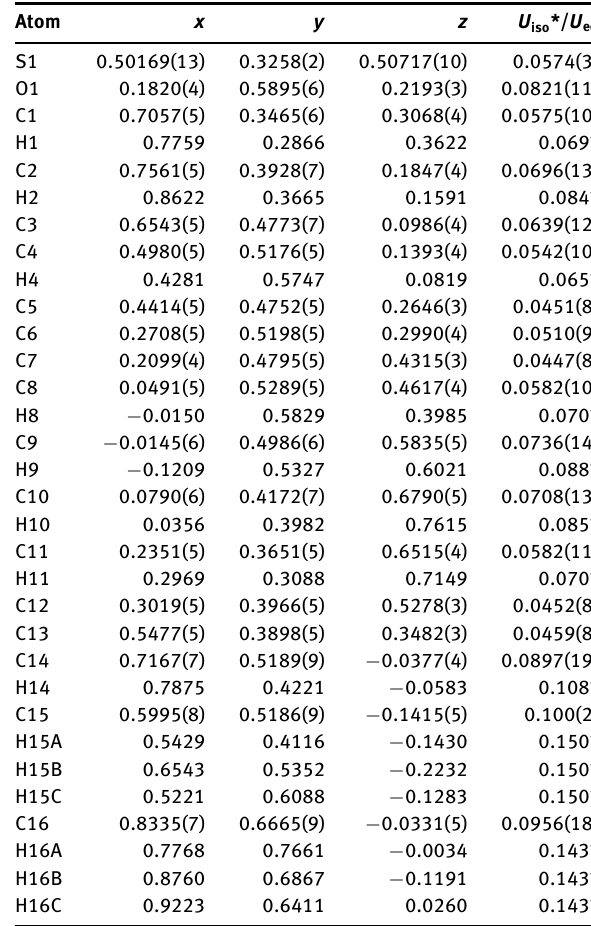
Table 2: Fractional atomic coordinates and isotropic or